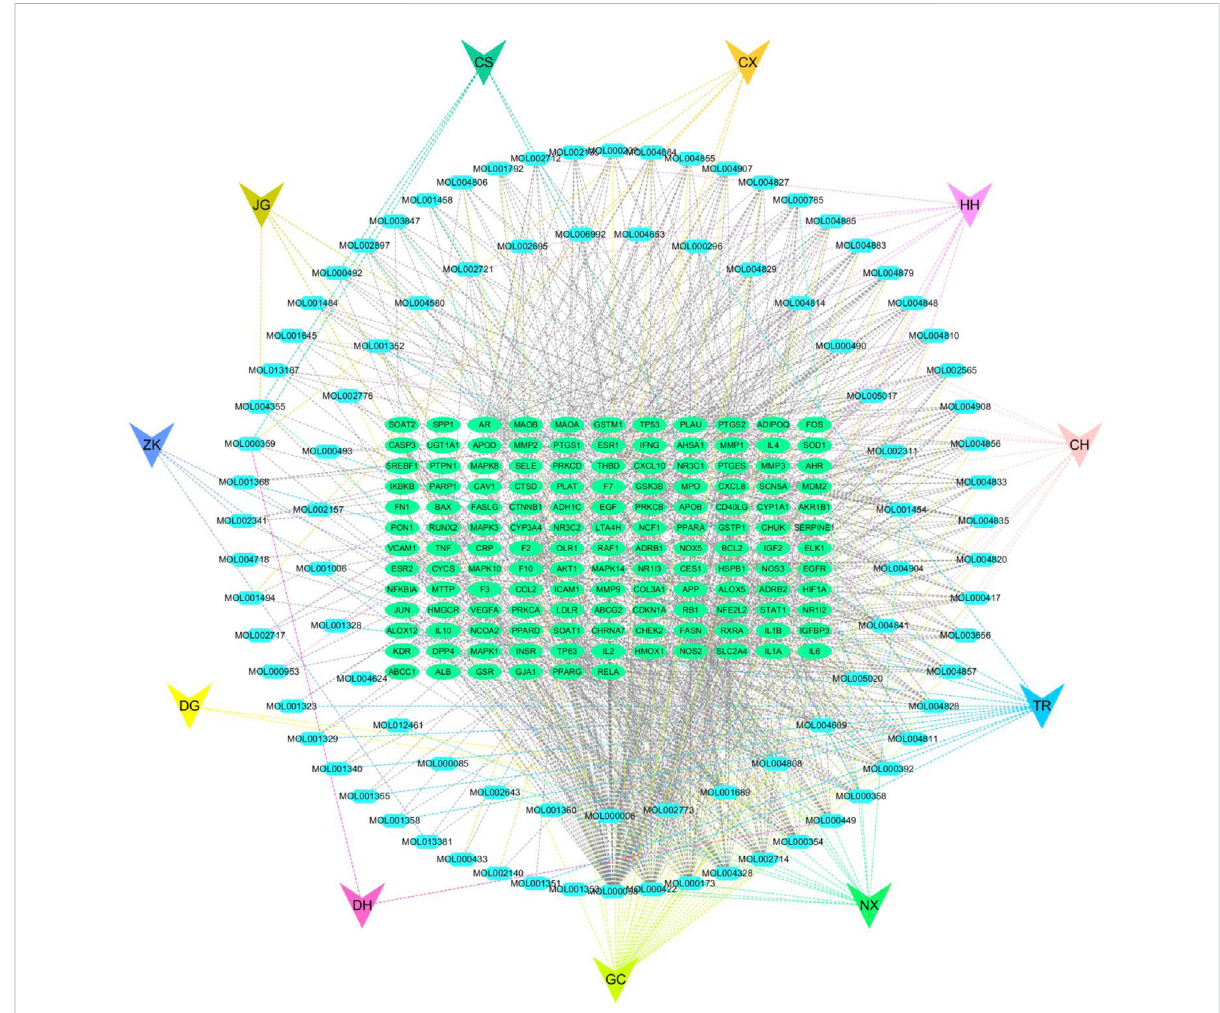
FIGURE 2 Active ingredient-active target network diagram of Xuefu Zhuyu